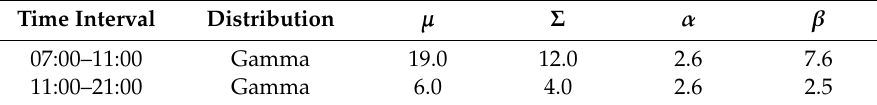
Table 3. Parameter of incoming electric vehicles (EVs)